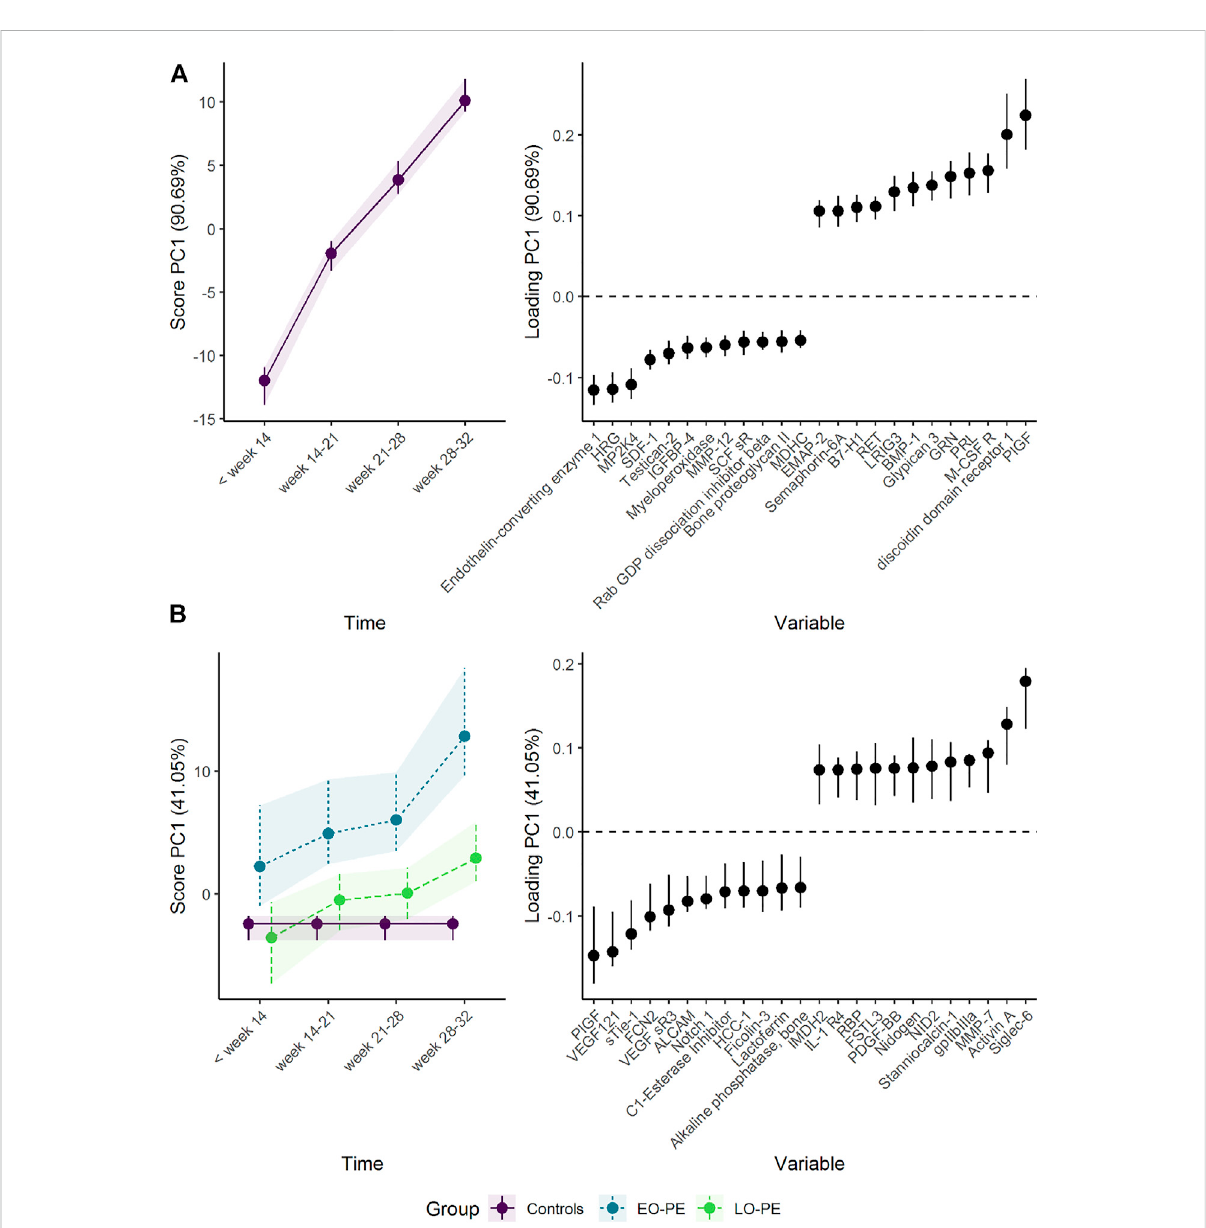
FIGURE 6 Time development of the plasma proteome throughout pregnancy in (A) healthy women and (B) women developing early-onset (EO-) or late- onset (LO-) preeclampsia (PE). The time development of healthy women is isolated in the upper panels, whereas the lower panels visualize how the plasma proteome differs between the groups. The plasma level of proteins with high loading is increasing when the scores increase and vice versa . Only the 12 proteins with highest and lowest loadings, separated by the vertical dotted line, are shown due to the large number of assessed